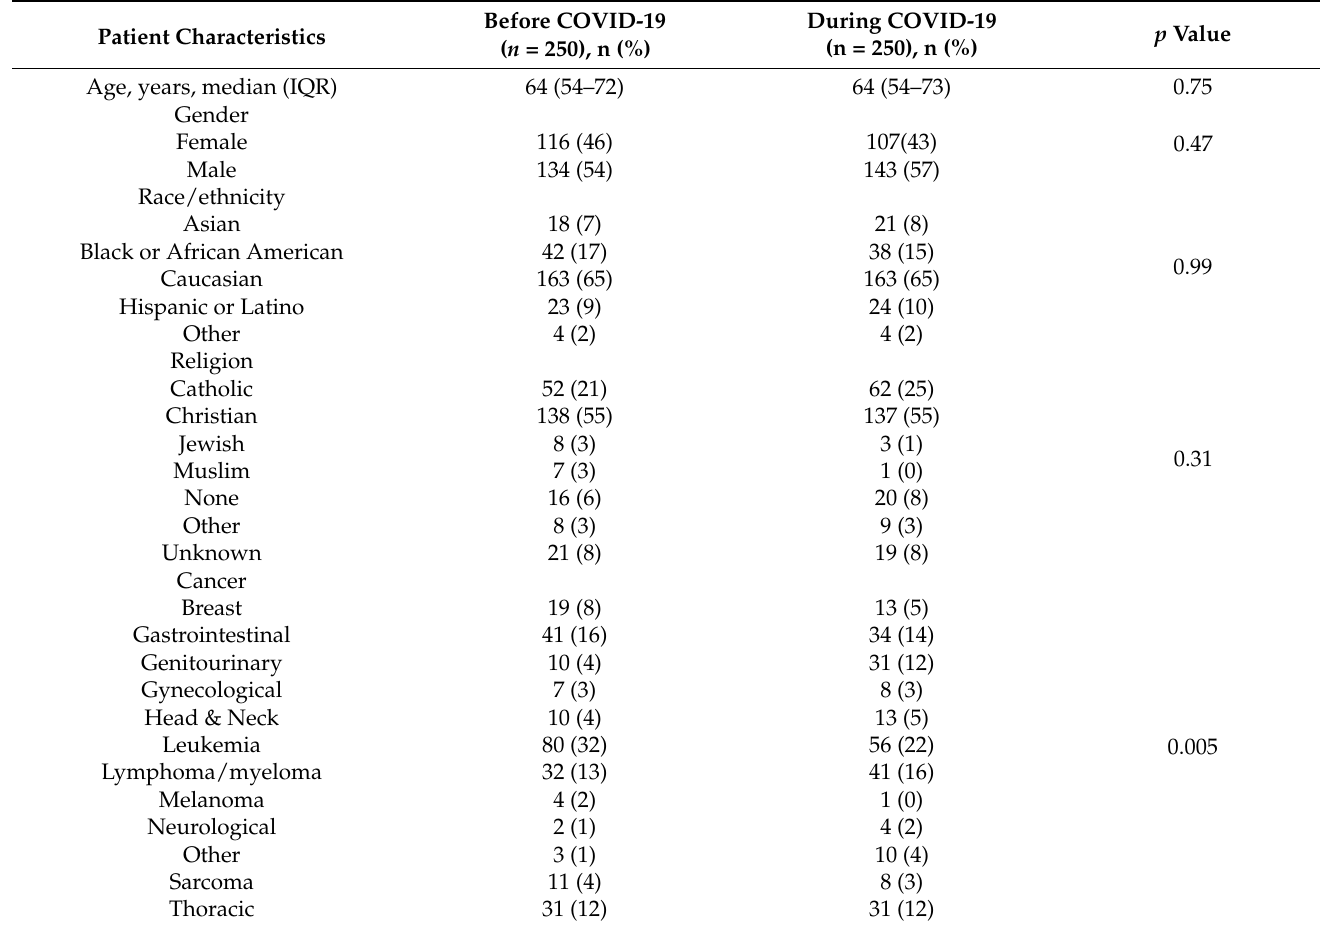
Table 1. Characteristics of inpatient deaths before and during the COVID-19 pandemic (n=500). Patient